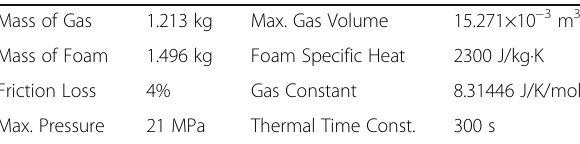
Table 1 Gas accumulator parameters [17]